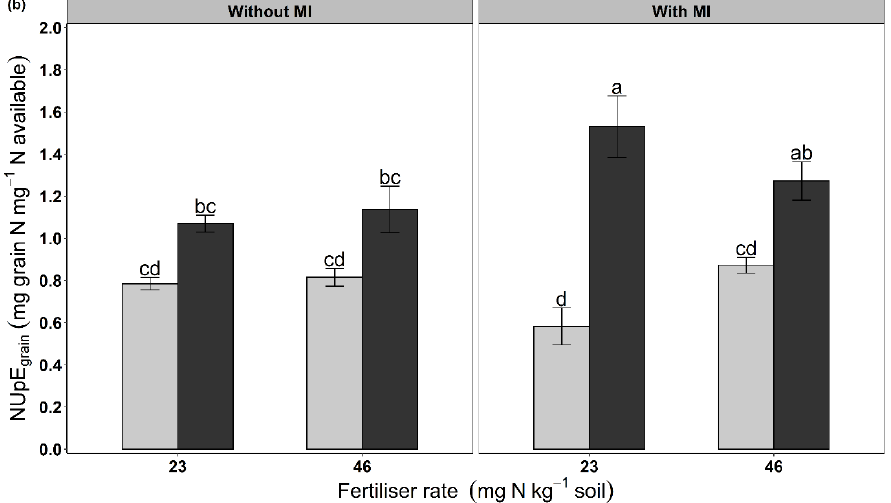
Figure 6. Effect of fertiliser type (Ft) × fertiliser rate (Fr) × microbial inoculant (MI) (mean ± SE, n = 12) on ( a ) N-use efficiency (NUE) and ( b ) grain N uptake efficiency (NUpE grain ). In ( a ) and ( b ) separately, mean values followed by the same letter are not statistically different as per Tukey’s HSD test at p ≤ 0.05. Three-way ANOVA (Table 1) showed significant interaction of Ft × Fr × MI on NUE ( p = 0.044) and NUpE grain ( p = 0.038). IF, inorganic fertiliser; RMF, rock mineral fertiliser; MT, microbial inoculant.